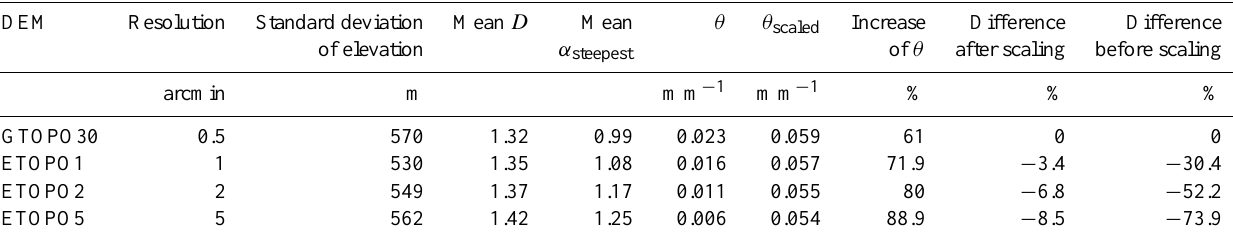
Table 2. Fractal parameters and the resulting mean global slopes before and after applying the fractal method on the different DEMs. Increase of slope means the increase of the average global slope of a DEM after applying the fractal method; difference after scaling = θ scaled ( DEM ) − θ scaled ( GTOPO30 ) θ scaled ( GTOPO30 )